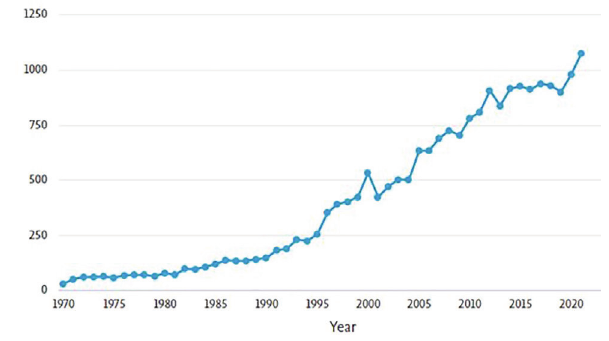
Figure 3 - Number of the citations by the